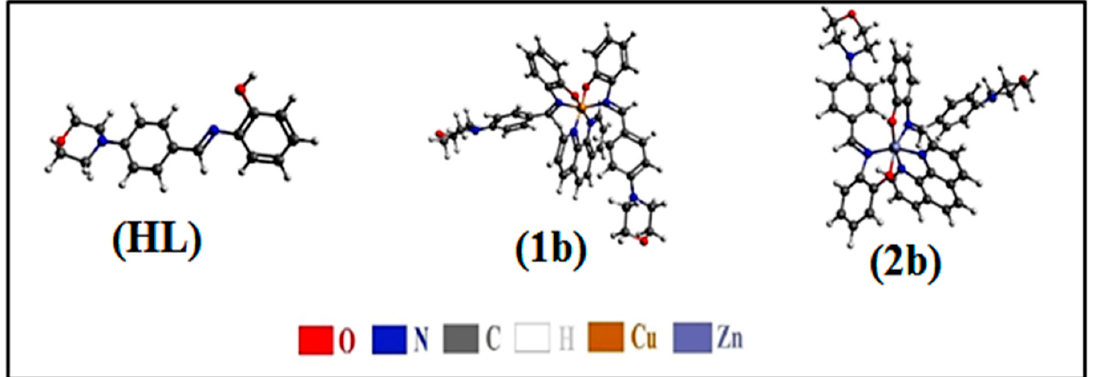
Figure 8. The optimized geometries of the free ligand ( HL ) and complexes ( 1b – 2b ).